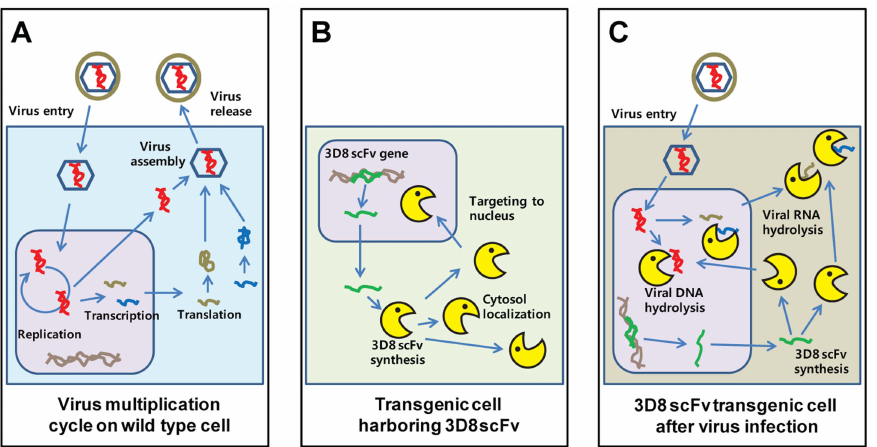
Figure 9. New antiviral mechanism by 3D8 scFv protein. A . Model of the HSV-I replication cycle. Virus infection begins with binding of the virus to the cell surface. The viral envelope fuses with the cell membrane and delivers the viral capsid into the cytoplasm. Viral DNA synthesis begins shortly after the appearance of the beta proteins and the temporal program of viral gene expression ends with the appearance of the gamma or late proteins, which constitute the structural proteins of the virus. Finally, the virus undergoes a lytic cycle. B . Expression model of 3D8 scFv proteins. 3D8 scFv proteins were localized in cytosol using a vector system and targeted in the nucleus by nuclear localization signal. Therefore, 3D8 scFv proteins in SCH07072 were present in both the cytosol and nucleus. C . 3D8 scFv has a unique dual and stereoscopic protection mechanism that includes DNase activity in the nucleus and RNase activity in the cytoplasm. 3D8 scFv acts by inhibiting (1) viral DNA replication and RNA transcription in the nucleus via viral DNA degradation and (2) translation in the cytoplasm via viral RNA degradation. In other words, 3D8 scFv targets the viral DNA genome itself or its RNA transcripts spatially in two different subcellular spaces (nucleus and cytoplasm) and at two different times.